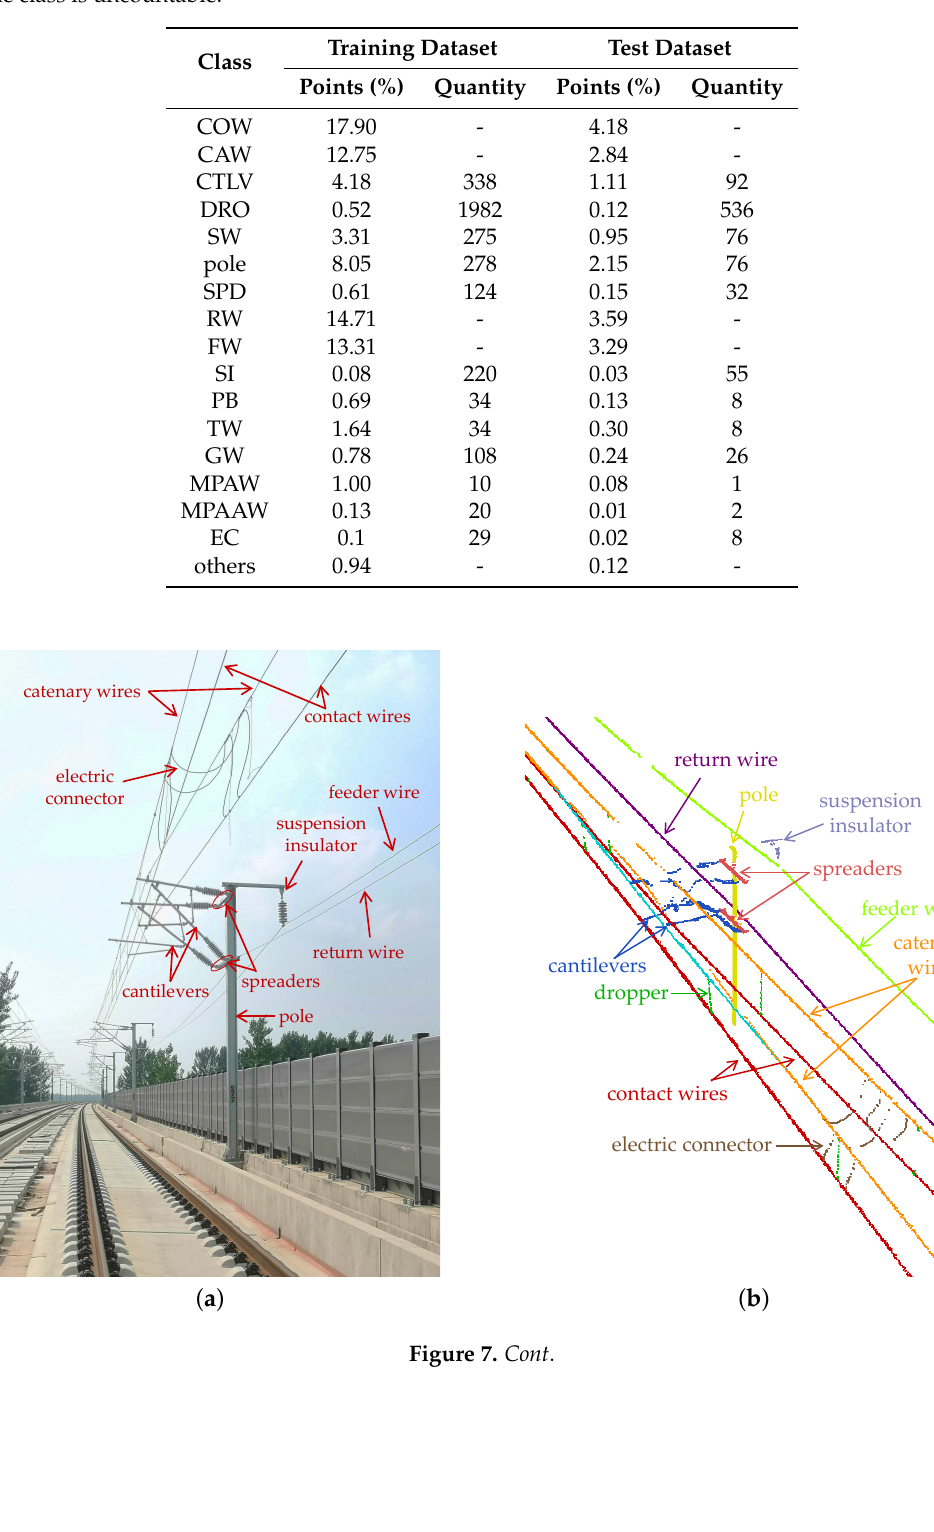
the class is uncountable.